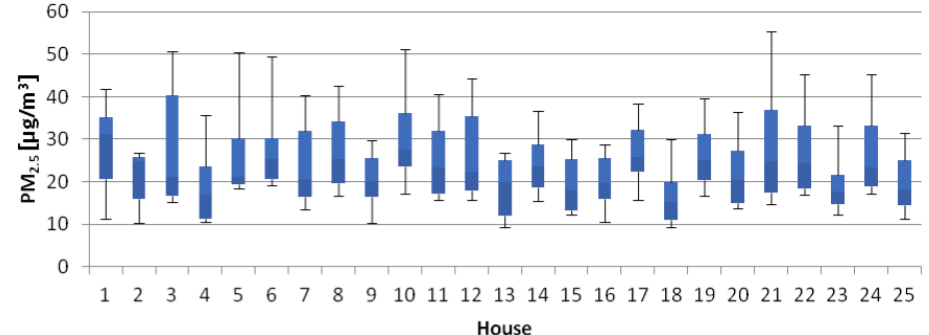
Figure 1. Box plot of PM 2.5 concentrations.